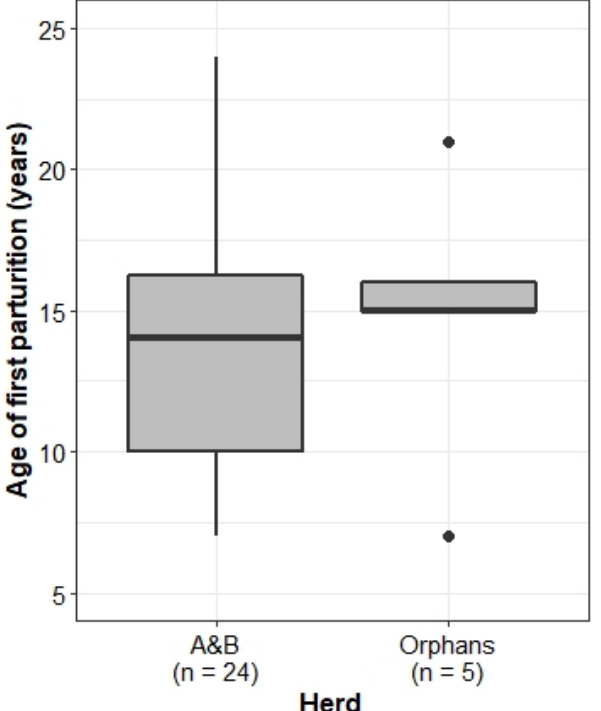
Figure 7. Age of the first parturition of females in the A&B herd and the Orphans. Boxplots show median, IQR, and outliers. Numbers on the x -axis indicate the number of individuals included in the analysis for each herd.